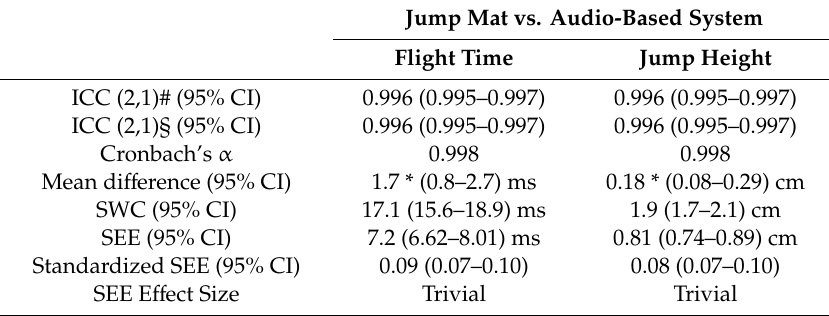
Table 3. Pairwise reliability of jump mat and audio-based system. Jump Mat vs. Audio-Based